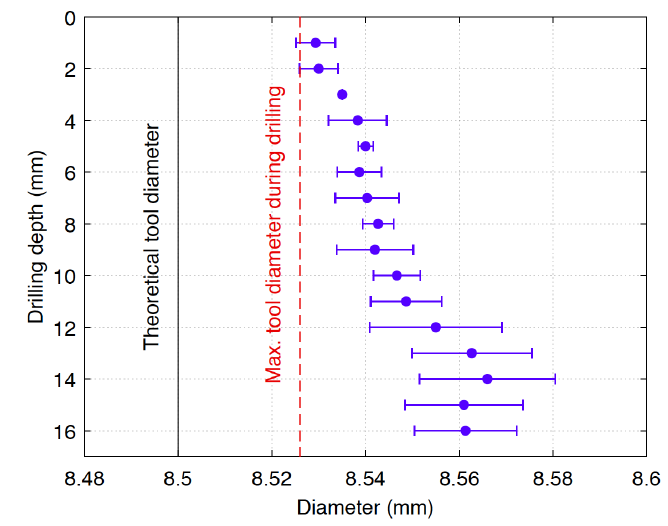
Figure 17. Distribution of experimental diameter after dry drilling.